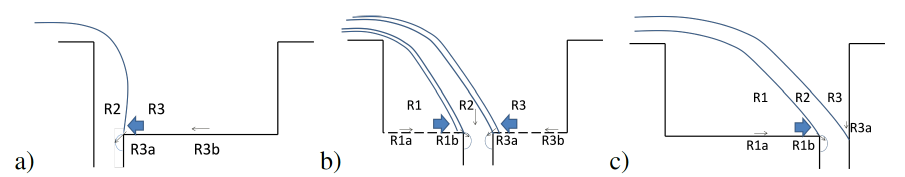
Figure 4. Regimes ( a ) R1, ( b ) R2, and ( c ) R3 according each